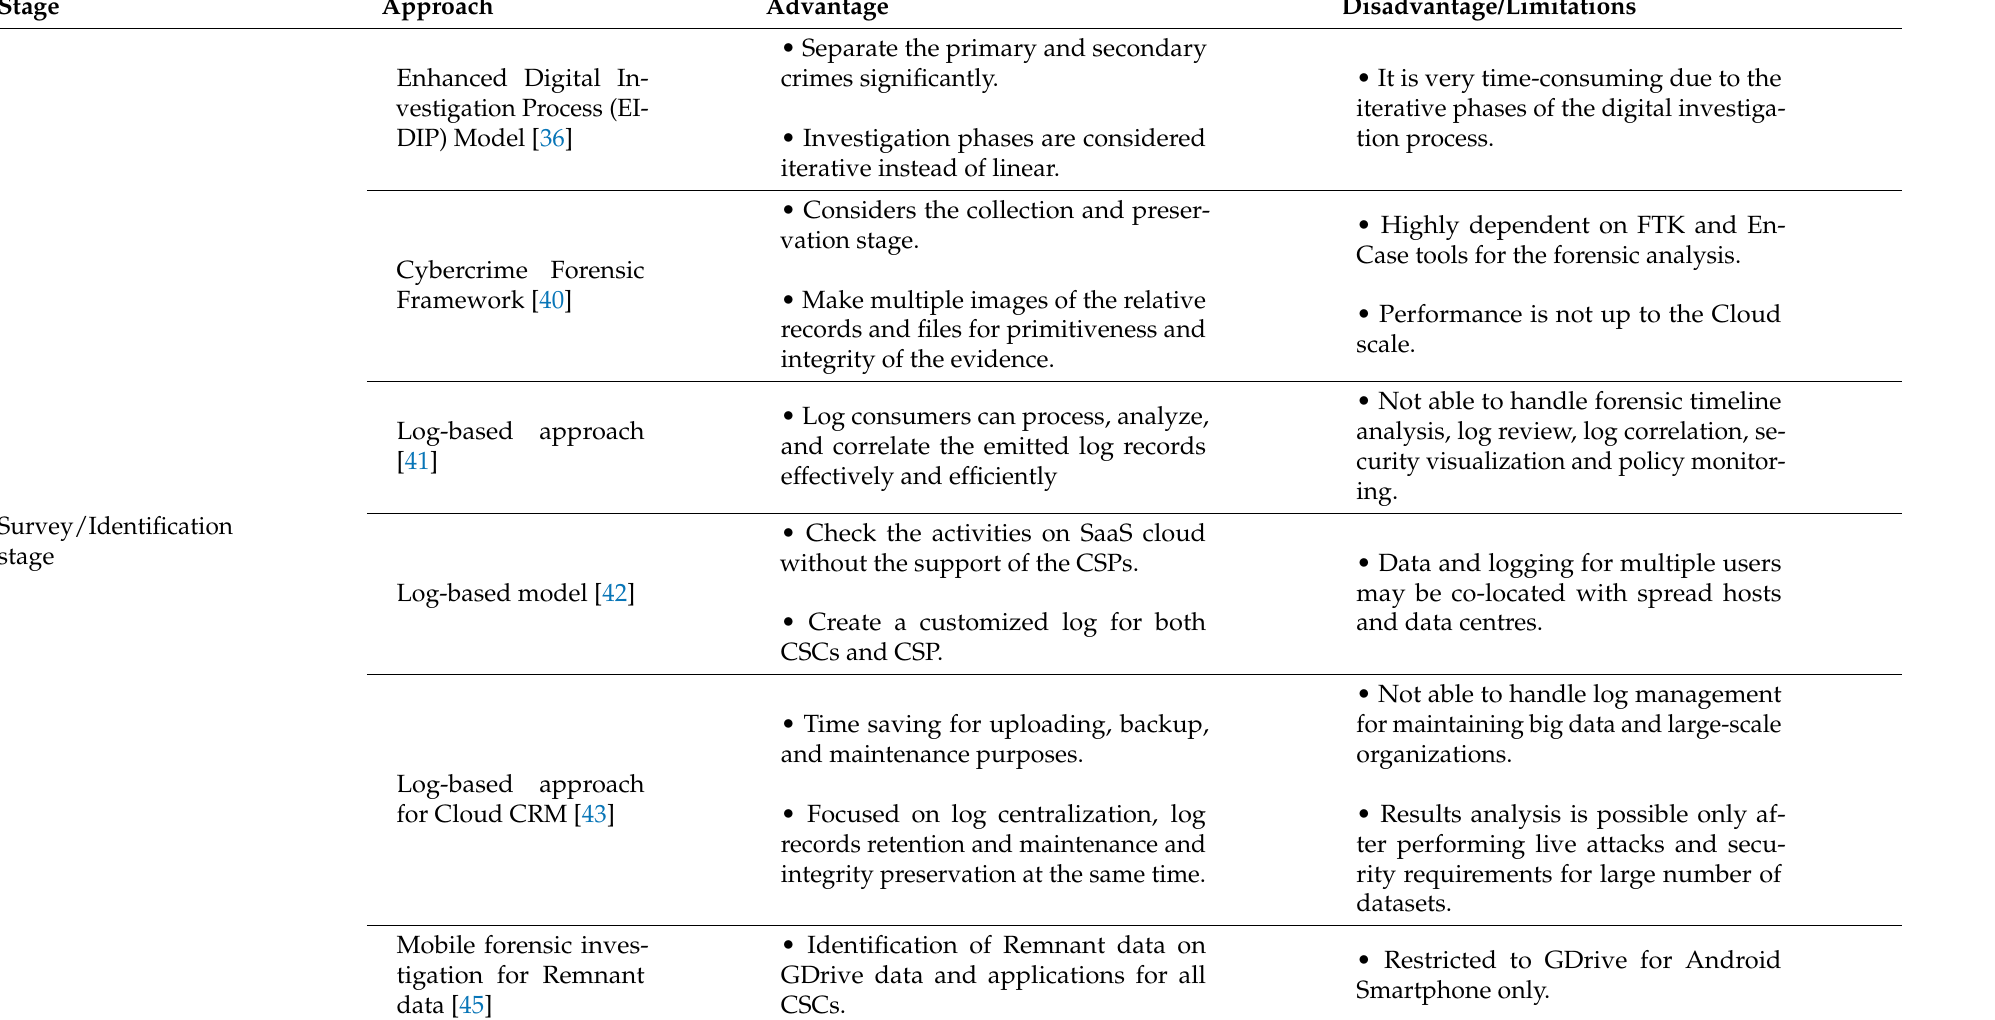
Table 2. Advantage/disadvantages of approaches used in the digital investigation forensic